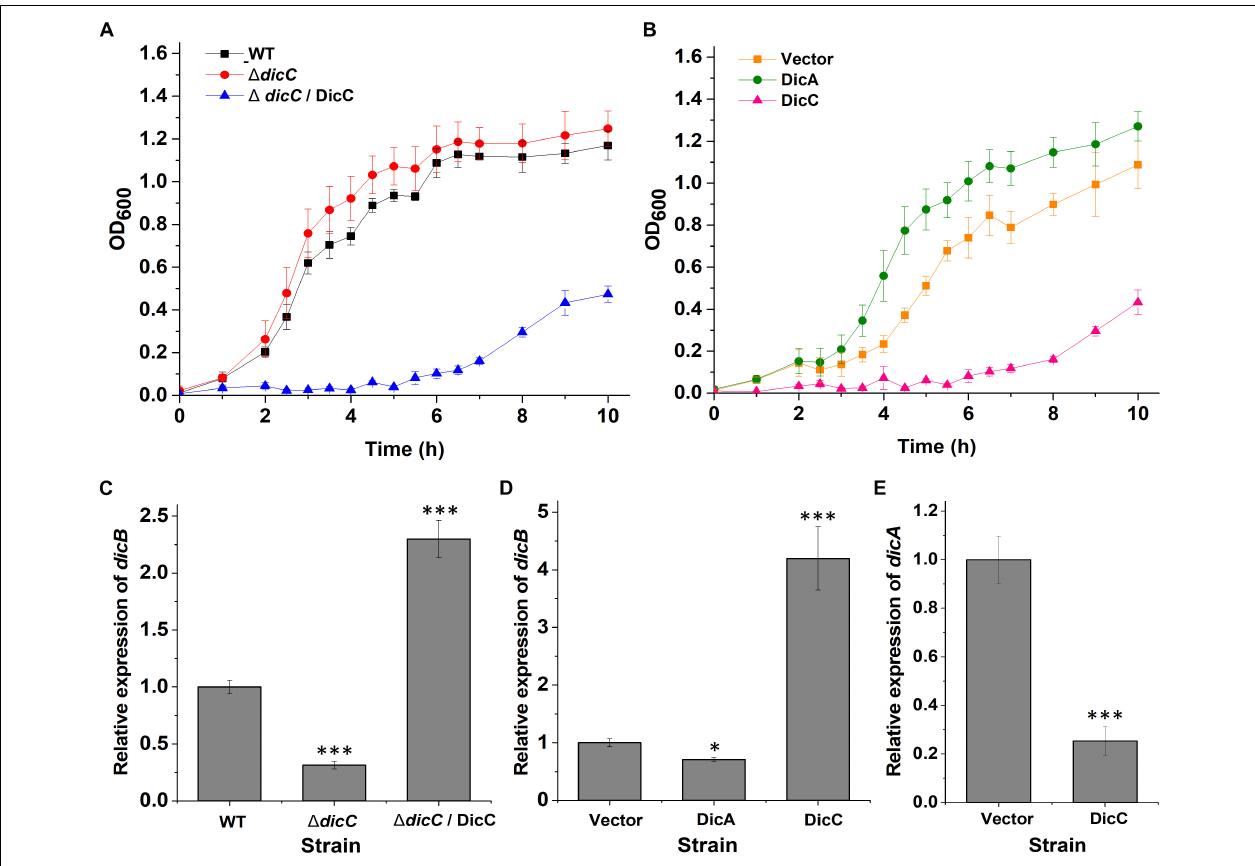
FIGURE 3 | Effect of DicA and DicC on the growth rate of E. coli O157:H7. (A) Growth curves of the WT E. coli O157:H7, (cid:49) dicC mutant and DicC complementary strains cultured at 37 ◦ C in LB. (B) Growth curves of the empty vector strain and DicA- and DicC-overexpressing strains cultured at 37 ◦ C in LB. (C) Detection of dicB gene expression in the WT, (cid:49) dicC mutant and DicC complementary strains by qPCR. (D) Detection of dicB gene expression in the empty vector strain and DicA- and DicC-overexpressing strains by qPCR. (E) Relative expression of the dicA gene in the empty vector strain and DicC-overexpressing strain. Error bars show the standard errors of the means. Significance was calculated by the t -test ( ∗ p < 0.05, ∗∗ p < 0.01, ∗∗∗ p <